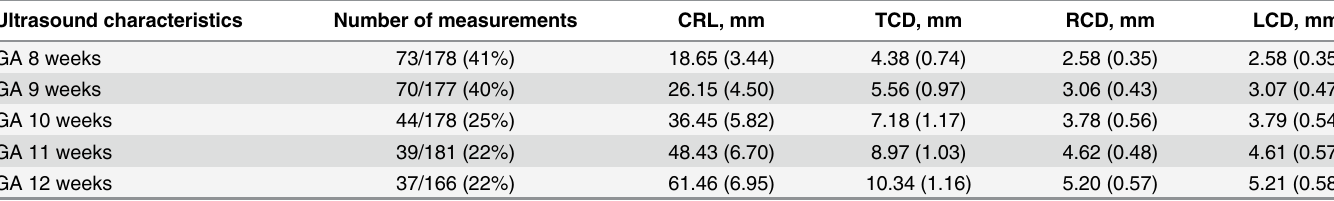
Table 3. Measurements per gestational week, with corresponding mean and SD values. Ultrasound